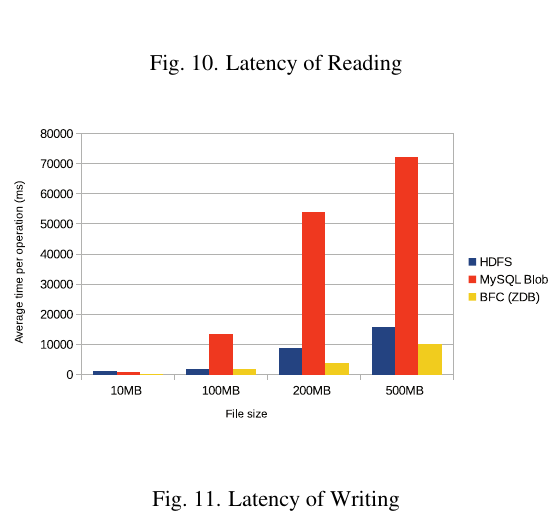
Fig. 11. Latency of Writing